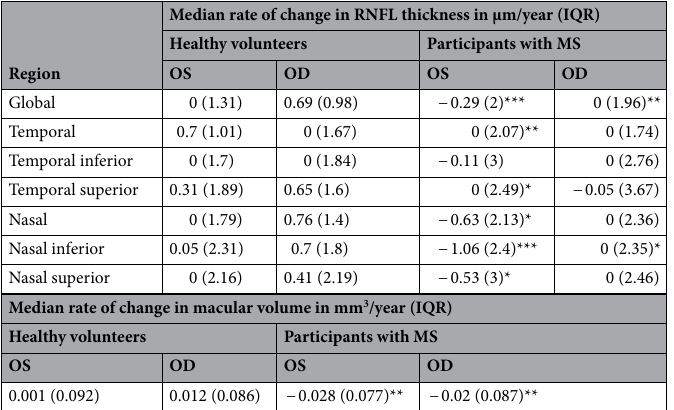
Table 6. Median annual RNFL thickness and macular volume changes seen in the three participant groups. OS, Left eye; OD, Right eye; ON, Optic neuritis; MS, Multiple sclerosis; SD, Standard deviation. p values: